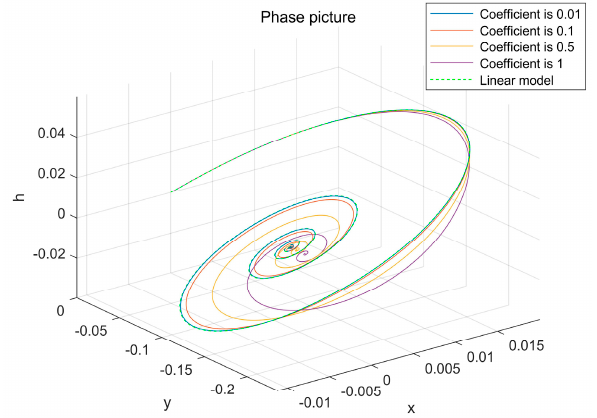
Figure 5. Phase diagram of system with different coefficients.